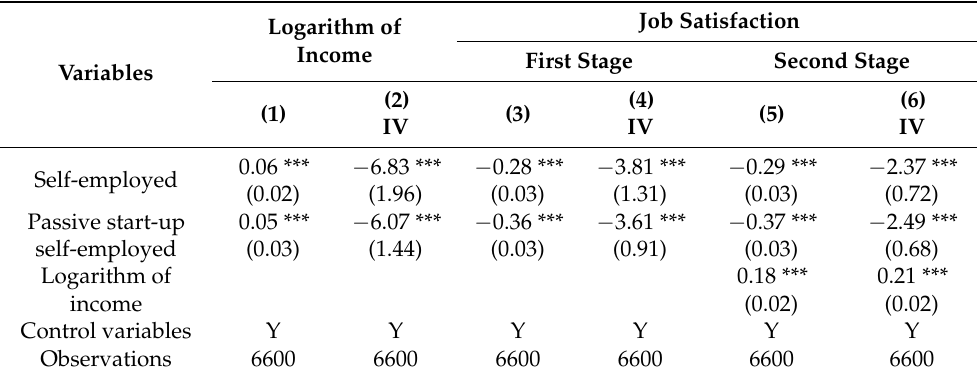
Table 10. 2SLS regression results of the effect of logarithm of income on job satisfaction for self- employed and passive entrepreneurial self-employed